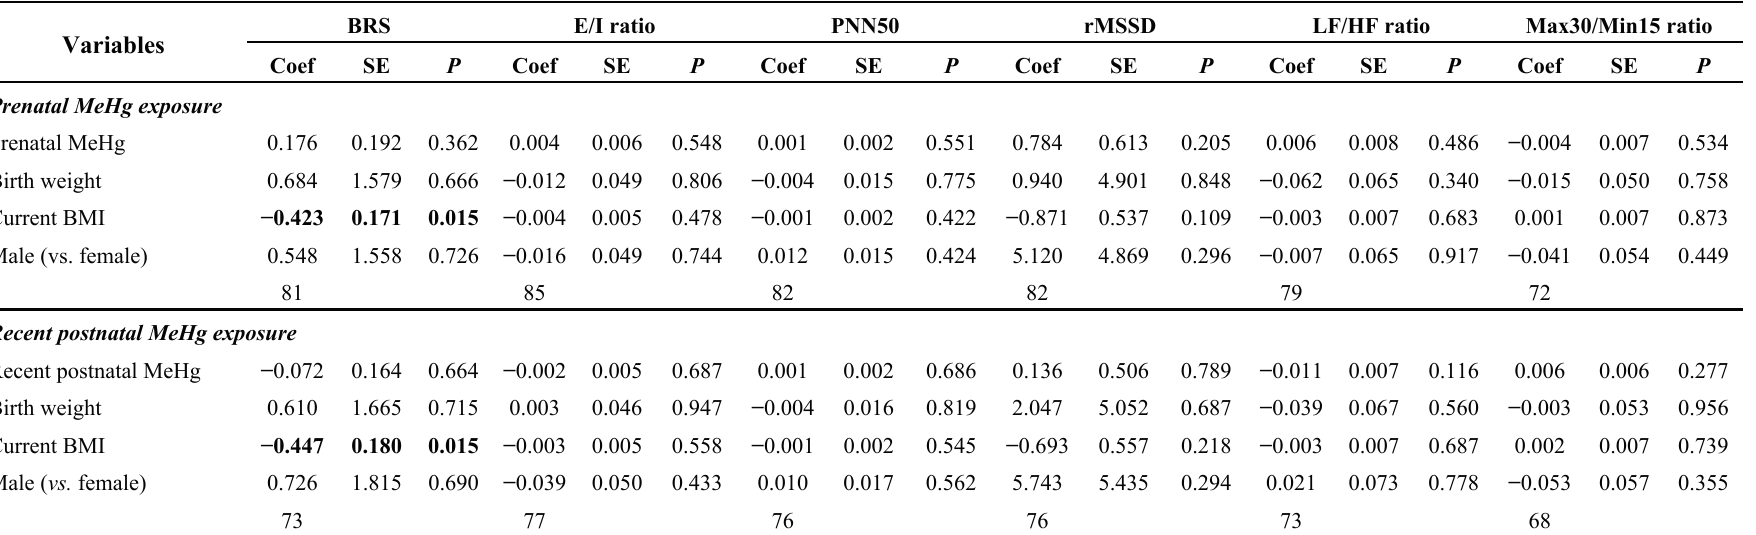
Table 3. Covariate-adjusted associations between prenatal MeHg exposure (top half of table) and recent postnatal MeHg exposure (bottom half of table) and baroreflex sensitivity, heart rate variability and initial orthostatic hypotension in young healthy adults in the Seychelles. Results for each outcome are fit in separate models adjusting for either prenatal MeHg or recent postnatal MeHg exposure. For rMSSD and prenatal MeHg exposure only, there was a significant sex by prenatal MeHg interaction, for which the prenatal MeHg slope was positive (Coef: 1.99) and significant ( P = 0.014) for males